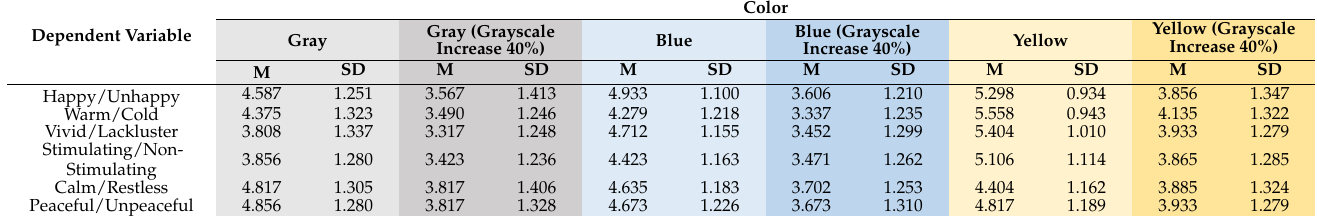
Table 4. Means and standard deviations of participants ’ ratings of emotional experience.